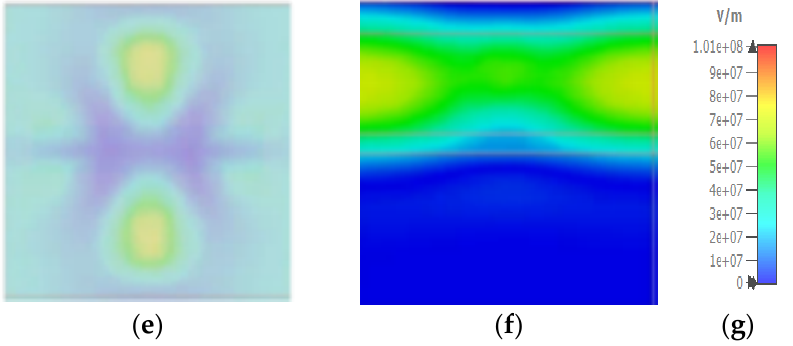
Figure 14. Electric field distribution at phase 560 ( a ) top SiO 2 layer ( b ) SiO 2 cover ( c ) Tungsten resonator ( d ) SiO 2 dielectric layer ( e ) Bottom tungsten layer ( f ) Side view of the MA unit cell ( g ) unit in V/m.